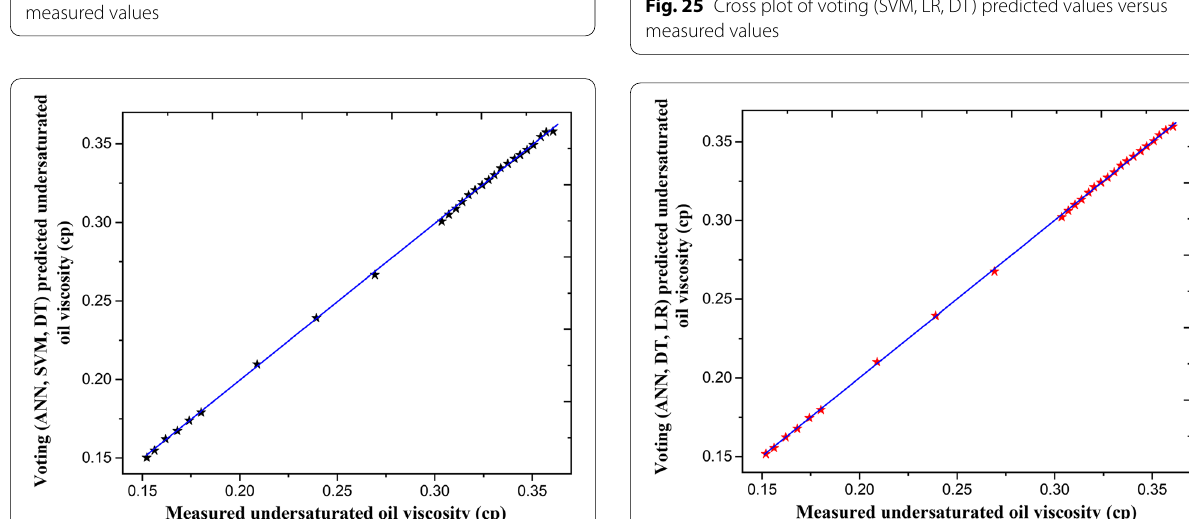
Fig. 26 Cross plot of voting (ANN, DT, LR) predicted values versus measured